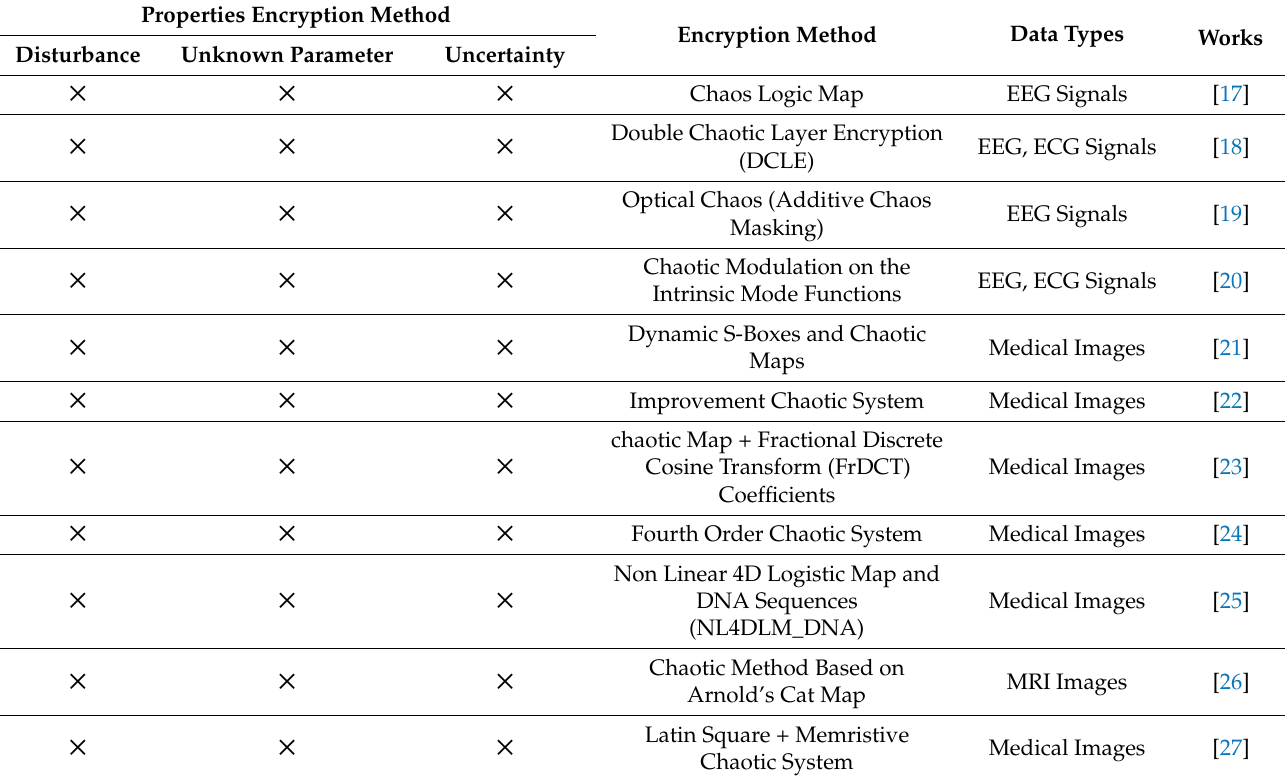
Table 6. Comparison of the proposed method with other related